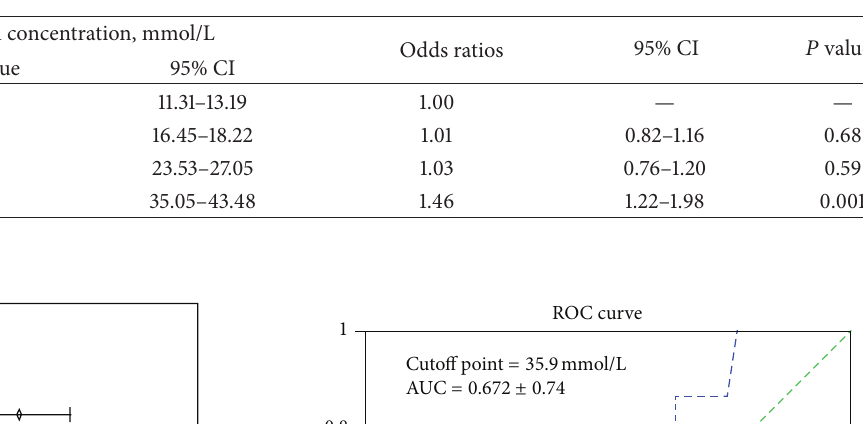
Table 4: Multivariable-adjusted odds ratios for vascular calcification examined by Agatston’ score index by SUA quartiles. Odds ratios are adjusted for age, sex, numerous damaged coronary arteries, creatinin plasma level, fasting glucose, HbA1c, type two diabetes mellitus, and total cholesterol calculated versus low quartile.